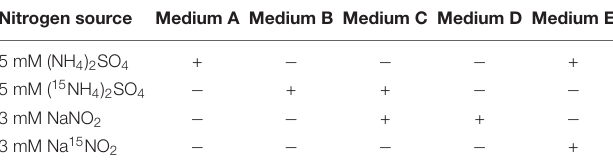
TABLE 2 | Nitrogen source used for different media.